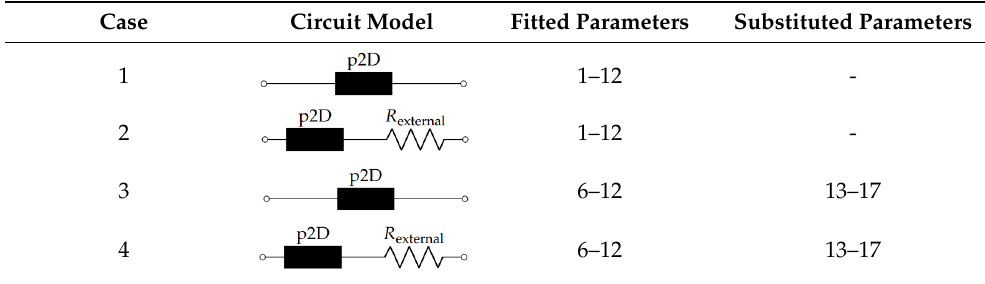
Table 3. Summary of the investigated model cases and fitted parameters.